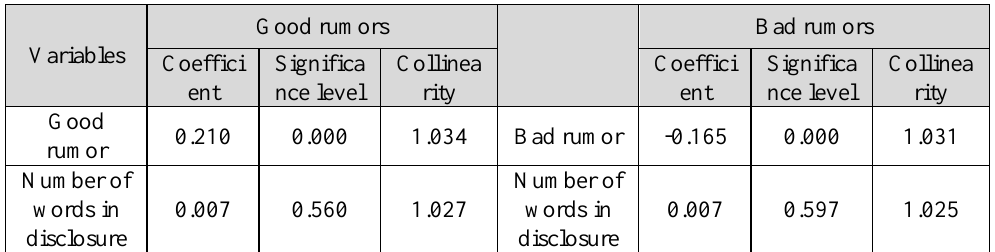
Table 6: Final estimation of the regressive model in the first major hypothesis (Good and bad rumors with abnormal return after 10